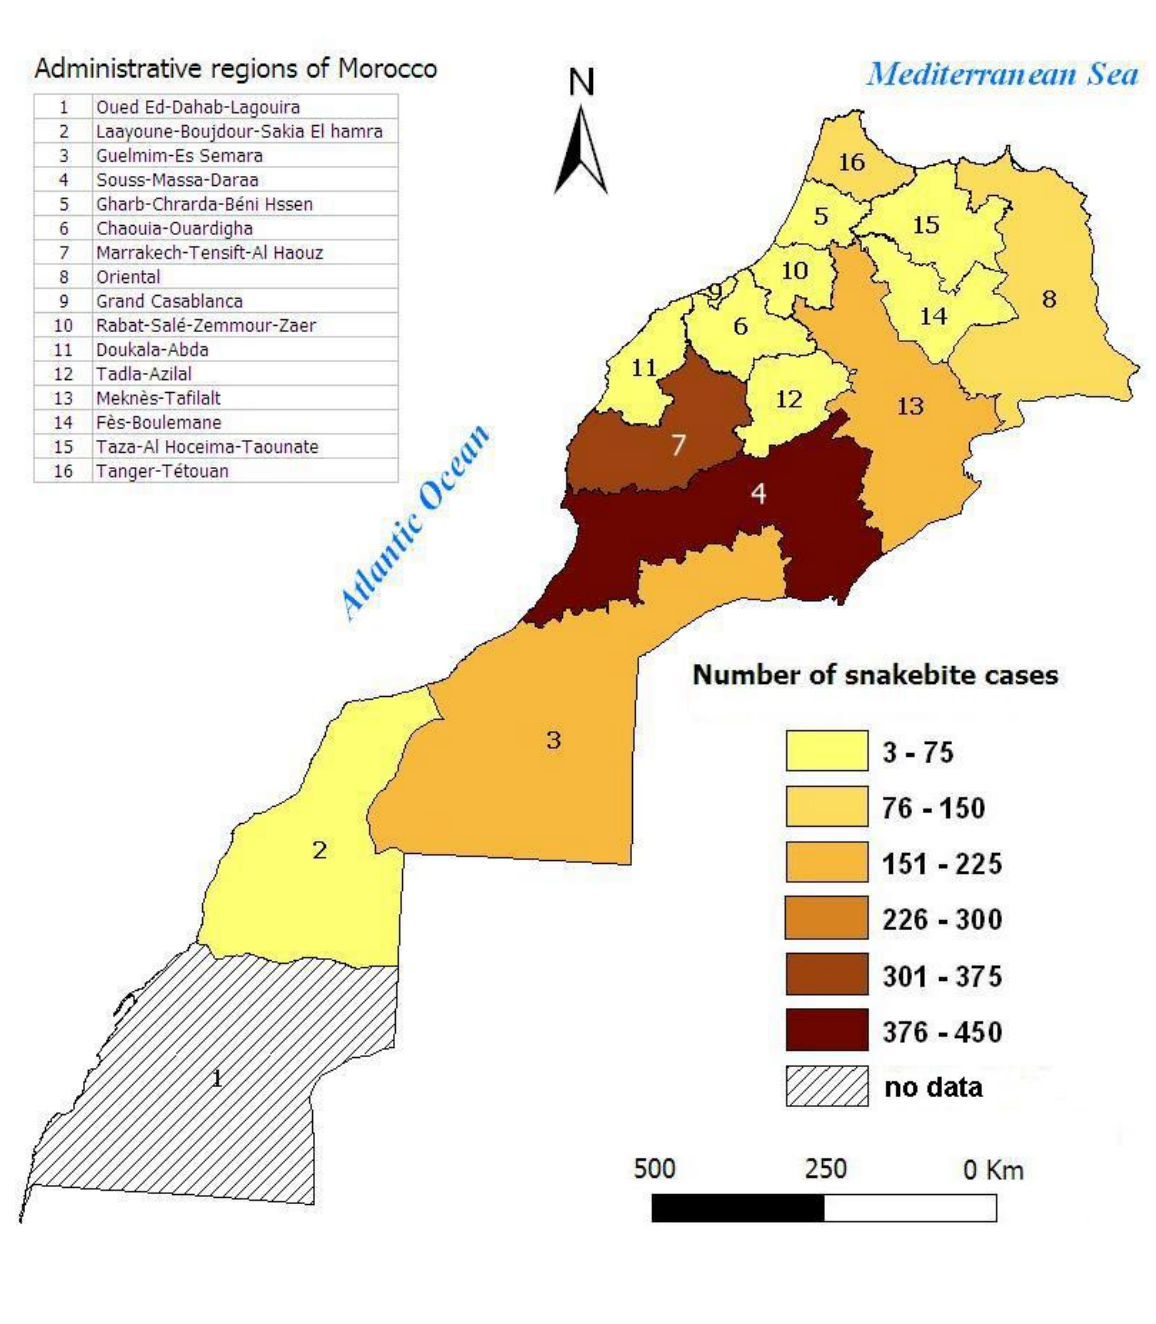
Figure 4. Distribution of snakebites by administrative region of